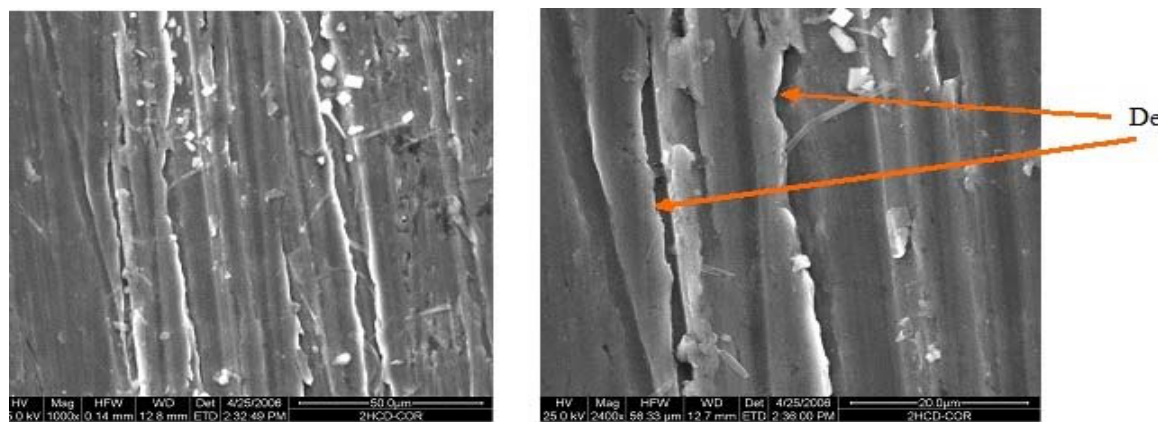
Figure 7. SEM of surface of 2hcd after polarization test in SBF.